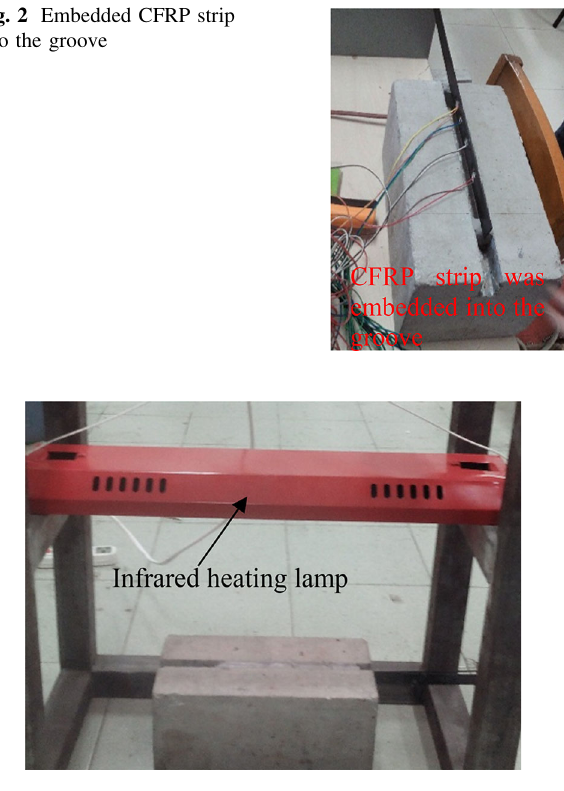
Fig. 3 Heated the specimen with the infrared heating lamp